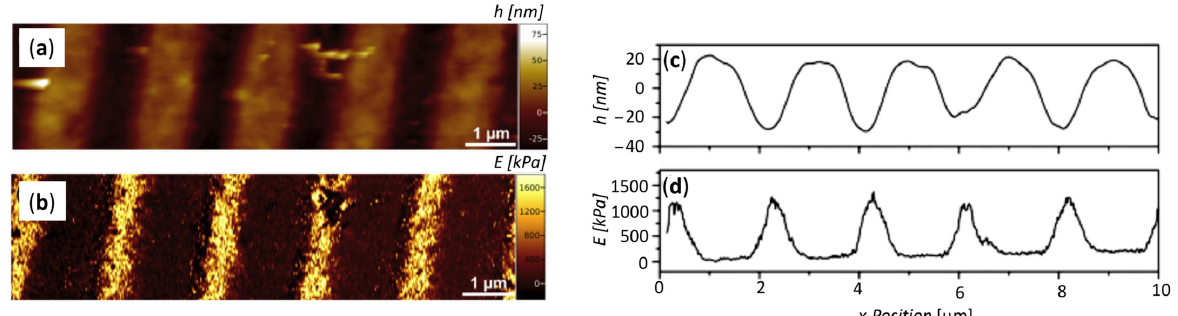
Figure 5. ( a ) Optical transmission microscopy images of a pattern produced with EBL on poly(amidoamine) (PAA) hydrogels. ( b ) Confocal microscopy images of PC12 cells (rat pheochromocytoma) treated with neural growth factor (NGF) (for 48 h), and immunostained with 4 ′ ,6-diamidino-2-phenylindole (DAPI, cell nuclei, blue), fluorescein isothiocyanate (FITC) anti-vinculin antibody (focal contacts, red), and tetramethylrhodamine (TRITC) phalloidin (actin filaments, red). Adapted from [27].